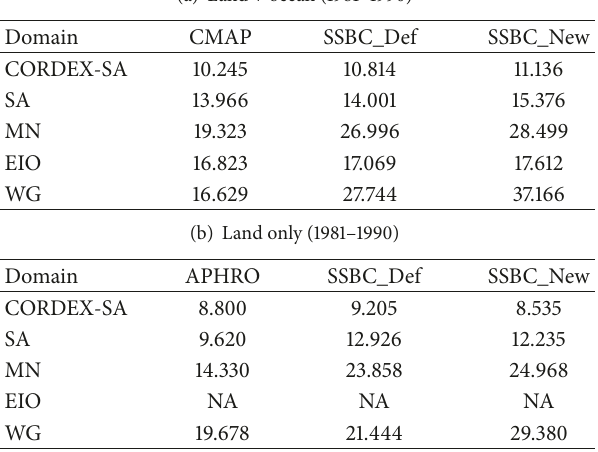
Table 7: 99th percentile statistics of surface precipitation for SSBC_Def and SSBC_New against CMAP and APHRODITE, 1981–1990. Units are in %